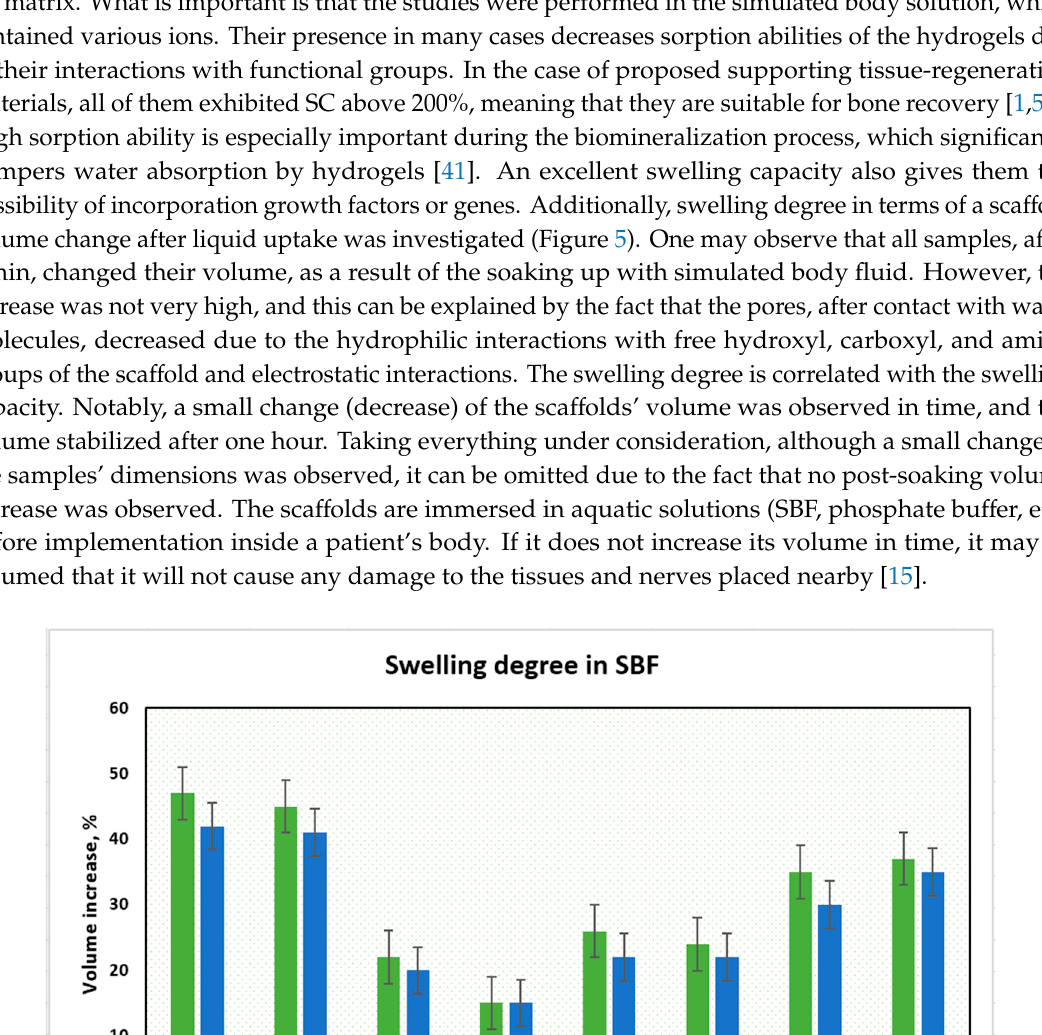
Figure 5. Swelling degree of the prepared samples.